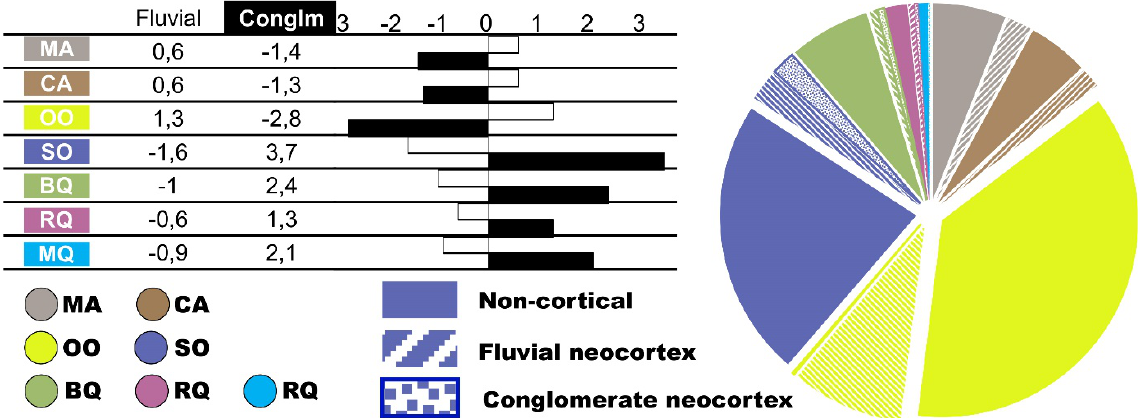
Figure 6. Preservation of cortical surfaces in Esquilleu Level XXII-R. On the left, standardise residues of χ 2 test of quartzites. On the right, pie chart representing the distribution of quartzites and cortex associated.